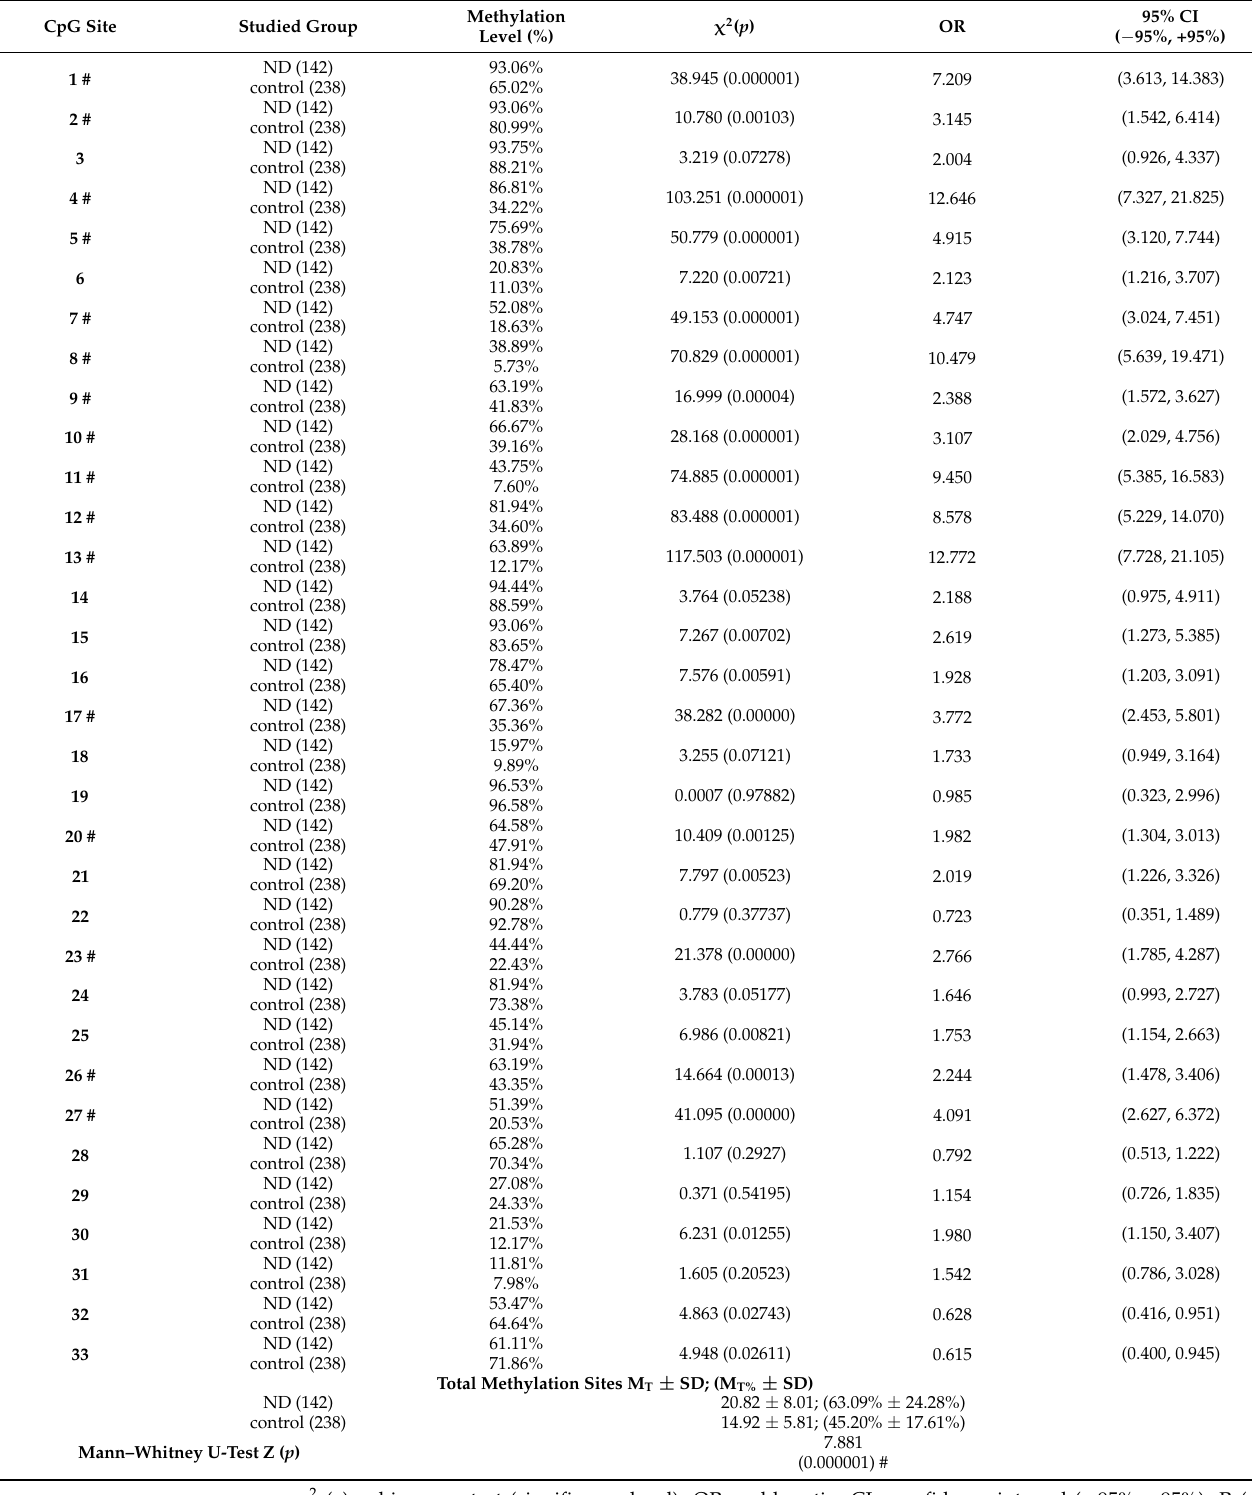
Table 3. The methylation status of 33 CpG DAT1 sites in a group of nicotine-dependent subjects (ND) and